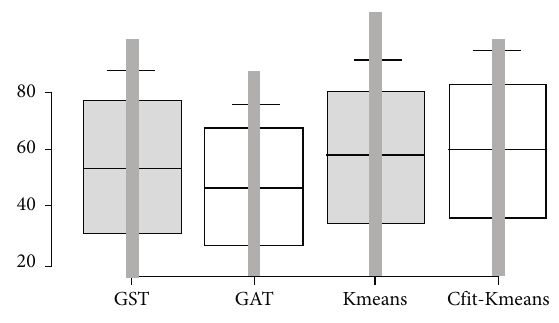
Figure 10: IoU score comparison for